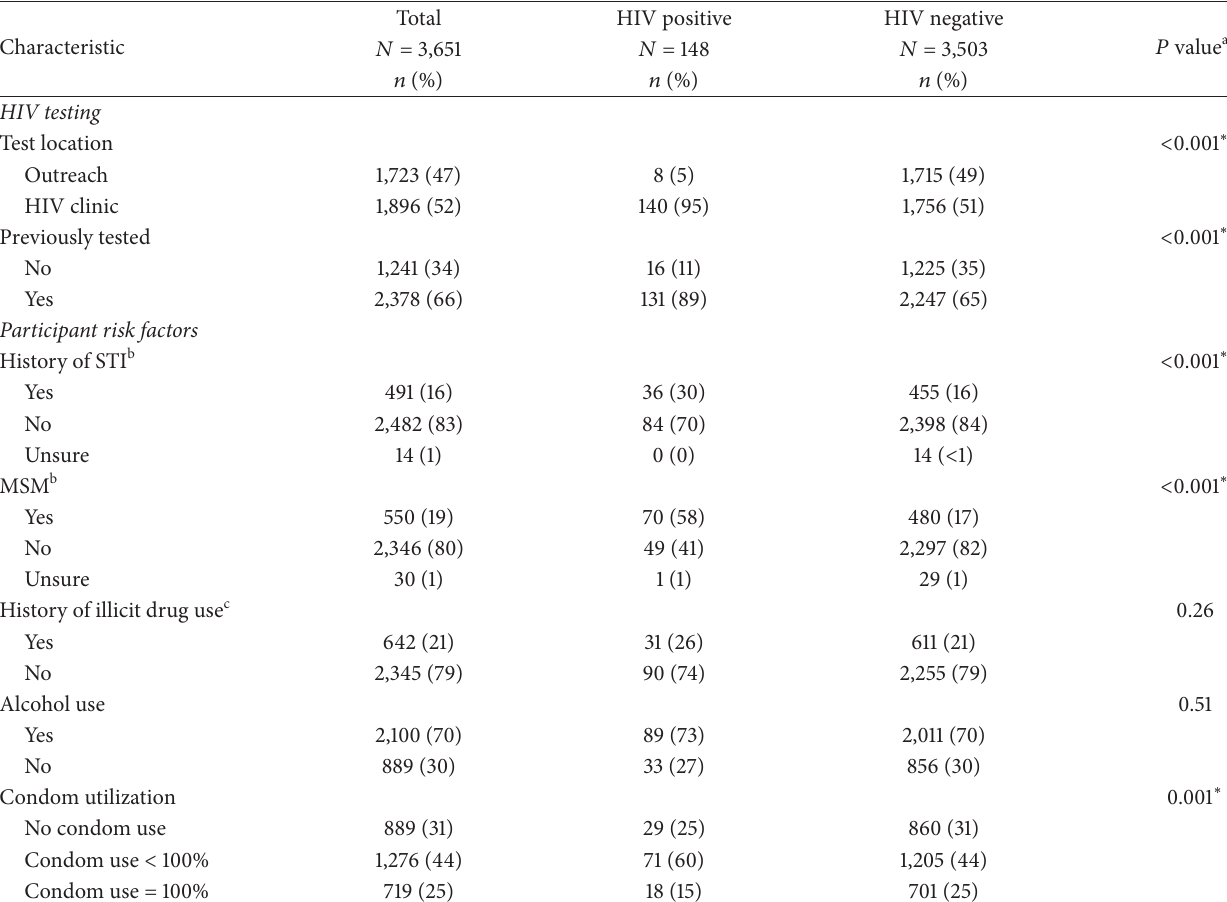
Table 3: Reported characteristics of clients who presented for HIV POC testing by test result, AL, 2007–2012.